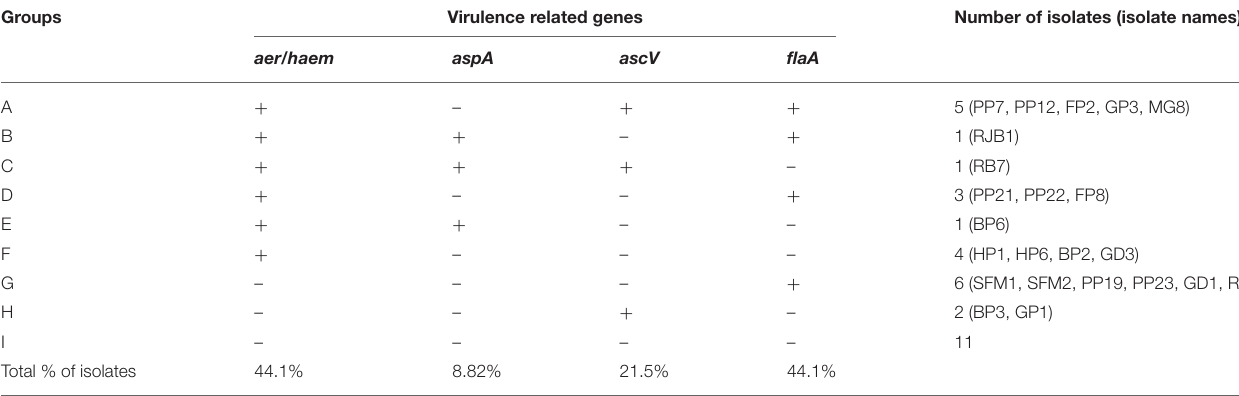
TABLE 1 | Aeromonas isolates summarized into groups based on occurrence of virulence genes. Groups